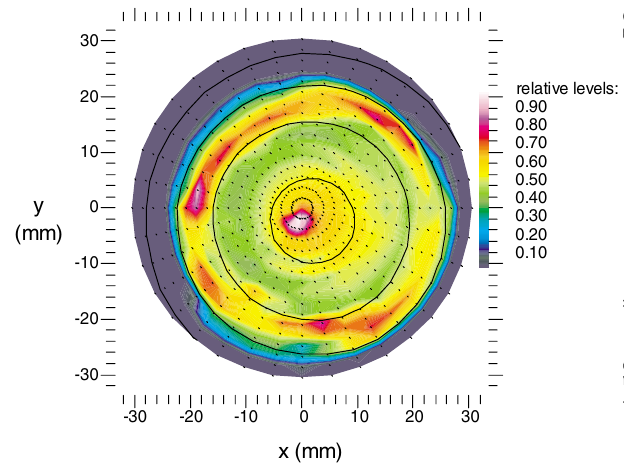
FIG. 7. (Color) Contour map of the beam current density profile 2.5 cm downstream of the extraction electrode for the 10-cm diameter contact-ionization source. Intensities are the mean of a 1 : 2 (cid:2) s window taken in the middle of the pulse. The data points are on a polar grid with a radial spacing of 1.9 mm.